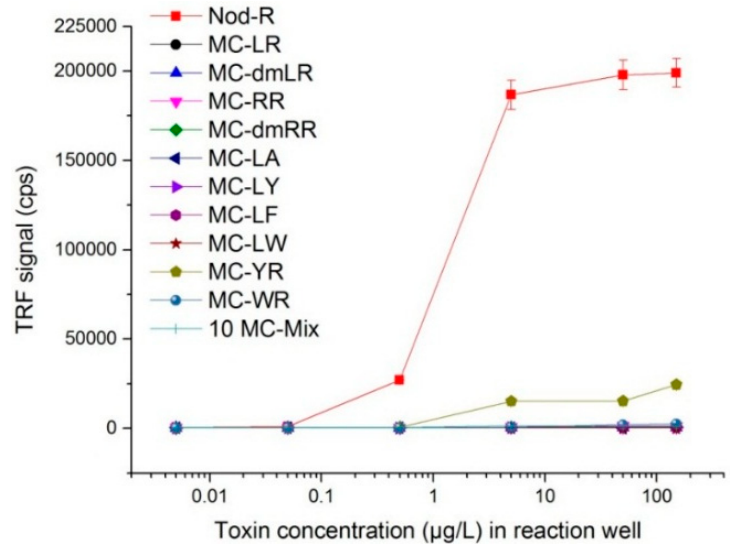
Figure 1. Cross-reaction profile of the anti-immunocomplex binder scFv-AP SA32C11 towards different cyanotoxins. The error bars represent the standard errors of means in the time-resolved fluorescence signals from duplicate measurements. The sample “10 MC-Mix” consists of an equimolar mixture of all the individually tested MCs (i.e., NOD not included). TRF: Time-resolved fluorescence. Cps: counts per second.